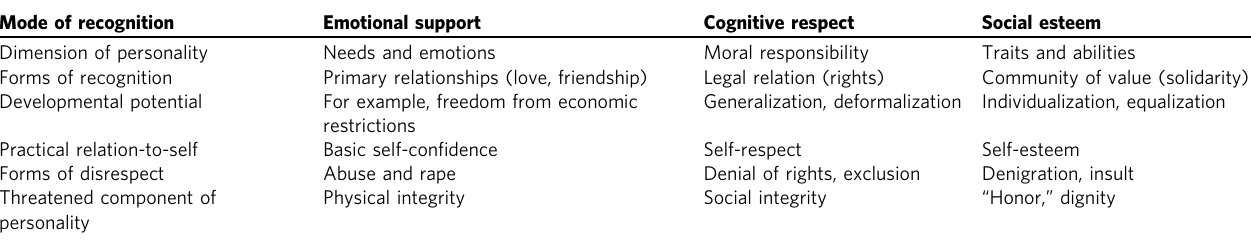
Table 1 Honneth ’ s theory of recognition (Herzog, 2020).